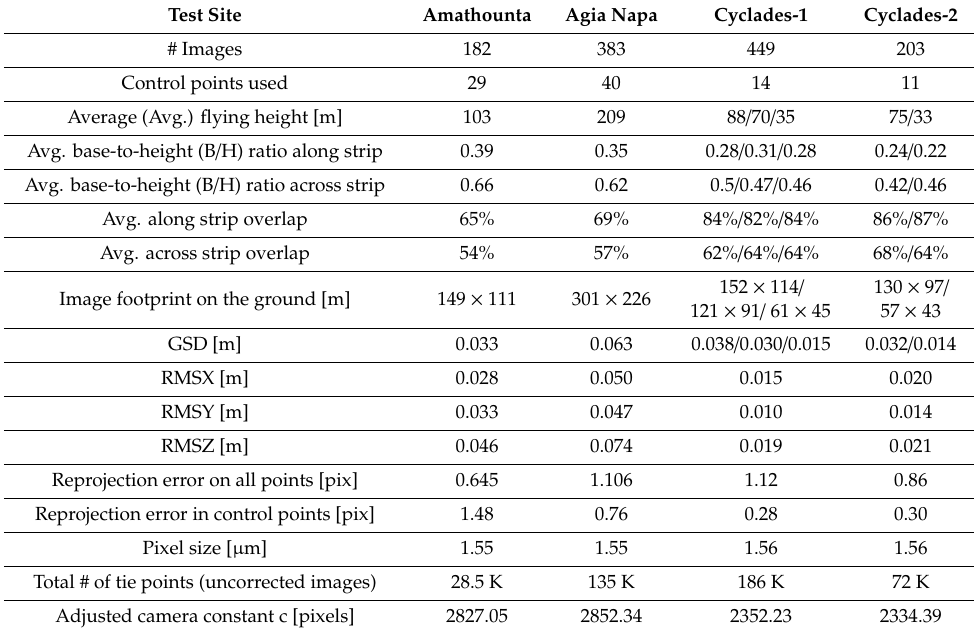
Table 1. The four aerial UAV campaigns, the derived datasets, and related